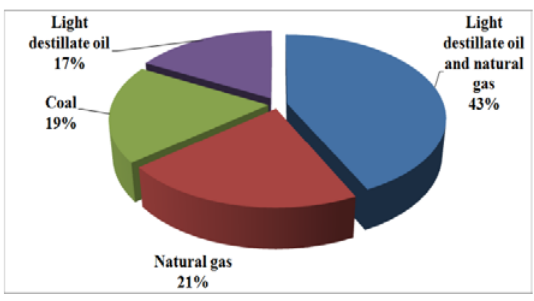
Figure 2. “Fuel used in thermal power plants”. Source: Croatian Electric Power